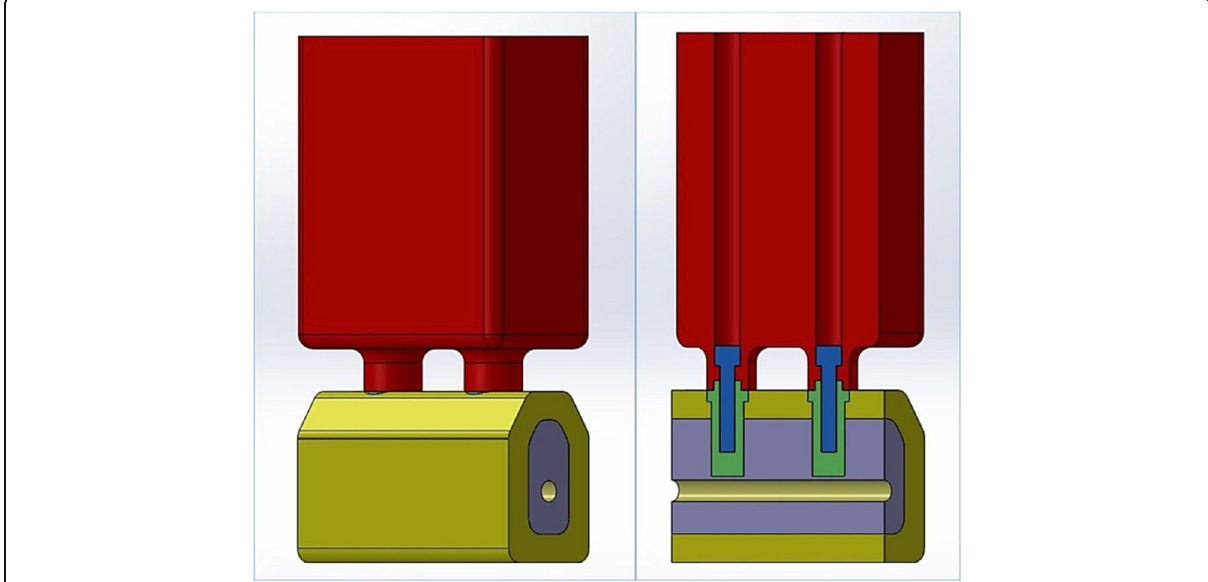
Fig. 1 Geometrical details of the study model. On the left: external cut-view of the model assembly. On the right: mesio-distal cut-view of the model exhibiting the internal aspects of the assembly: cortical bone (yellow), trabecular bone (purple), implants (green), implant screws (blue) and prosthetic framework (red). It is also possible to observe the implant screw channels and the mandibular